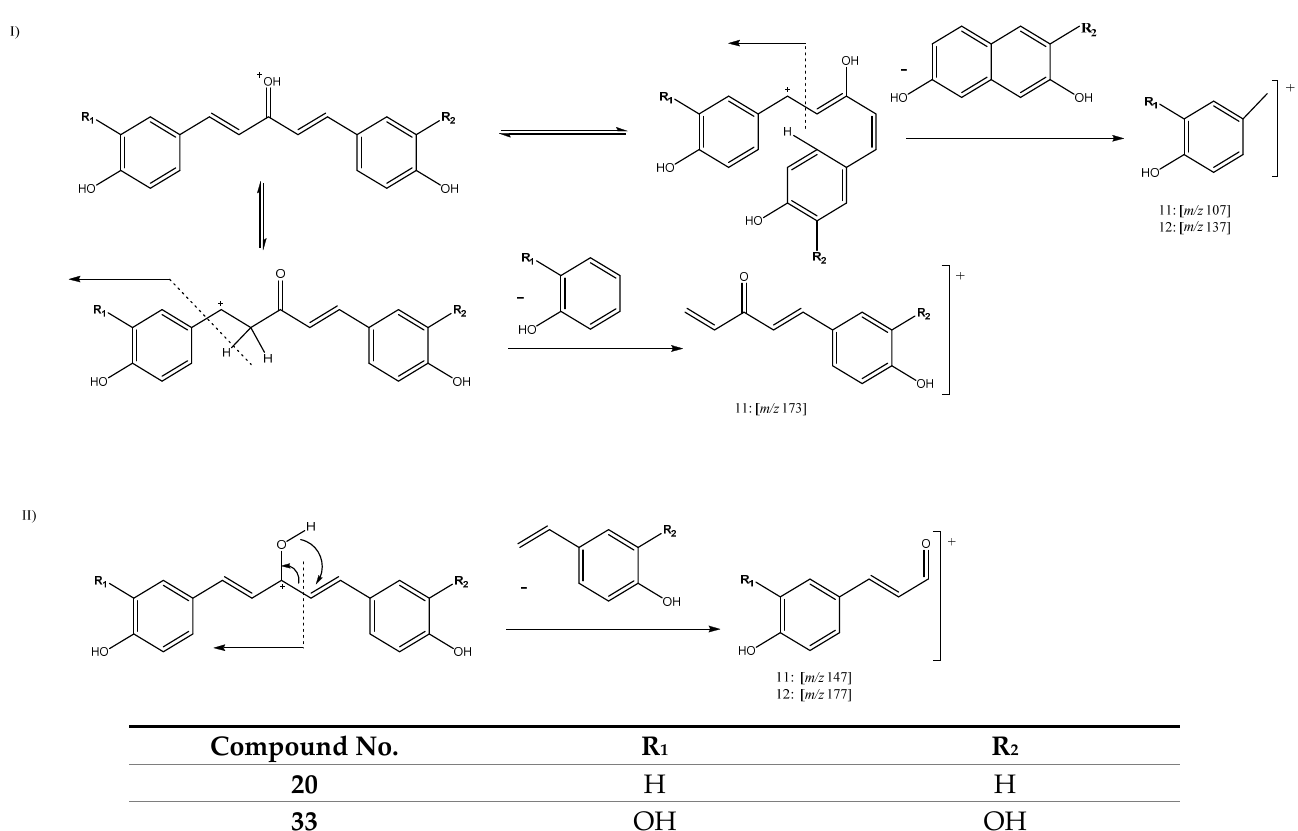
Figure 10. Fragmentation pathways I and II for compounds 20 , 33